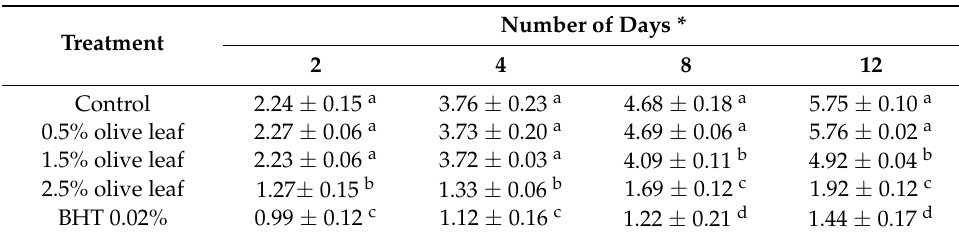
Table 2. Effect of the olive leaf extract on TBA values (mg MDA /kg) of the sheep meat slides stored at 5 ◦ C for 12 days.